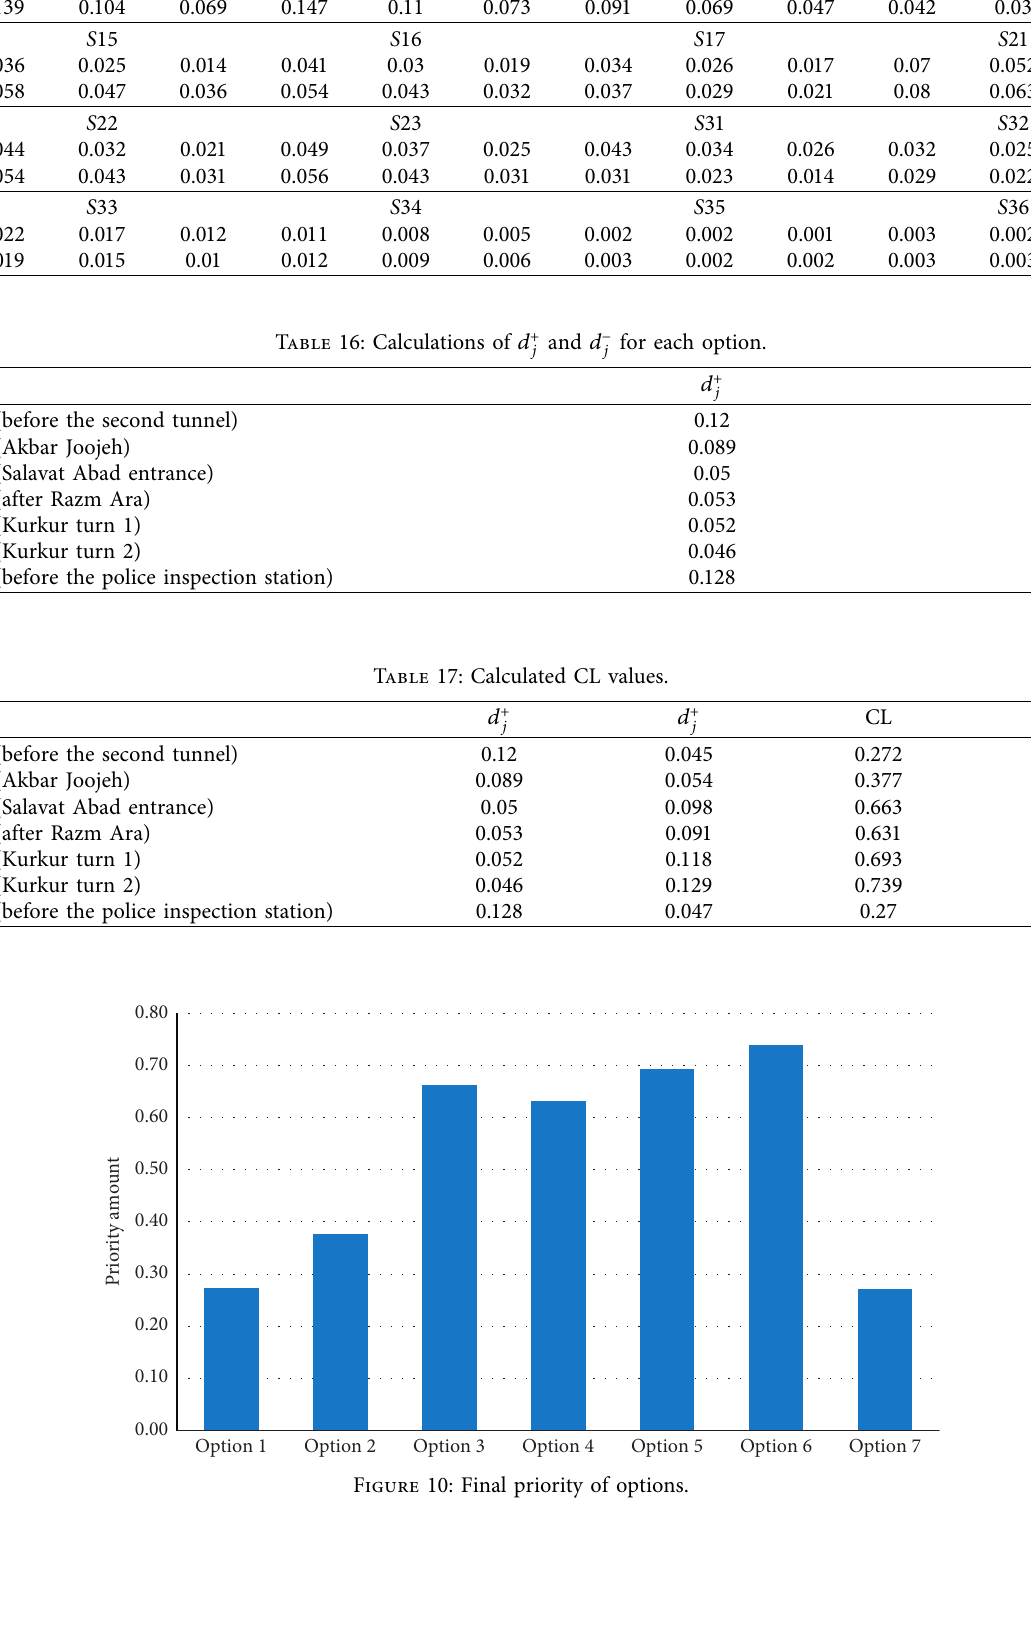
Table 15: Positive and negative ideal solutions